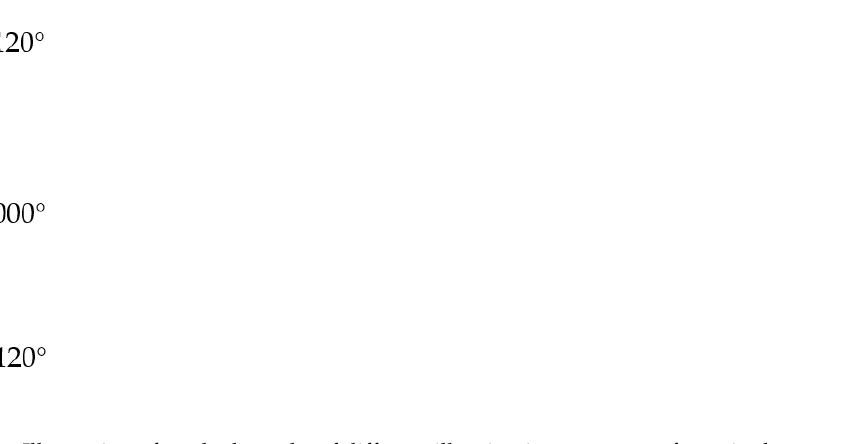
11 of 16 Figure 8. Grouped images of A+120--120E+00. 4. Experimental Results Figure 9 is a stacking diagram of LBPH’s A+120--120E+00 grouping error rate com- parison of different ambient light levels. Figure 10 illustrates the stacking method of Fig- ure 9. The bottom of the stacked image is the azimuth +120°, the center white block is the azimuth +000°, and the top is the azimuth − 120°. The recognition error rate is lower closer to the center white block, and higher otherwise. Therefore, the recognition error rates of the uppermost and the lowermost blocks are the highest, and the recognition error rate decreases as the azimuth angle approaches +000°.